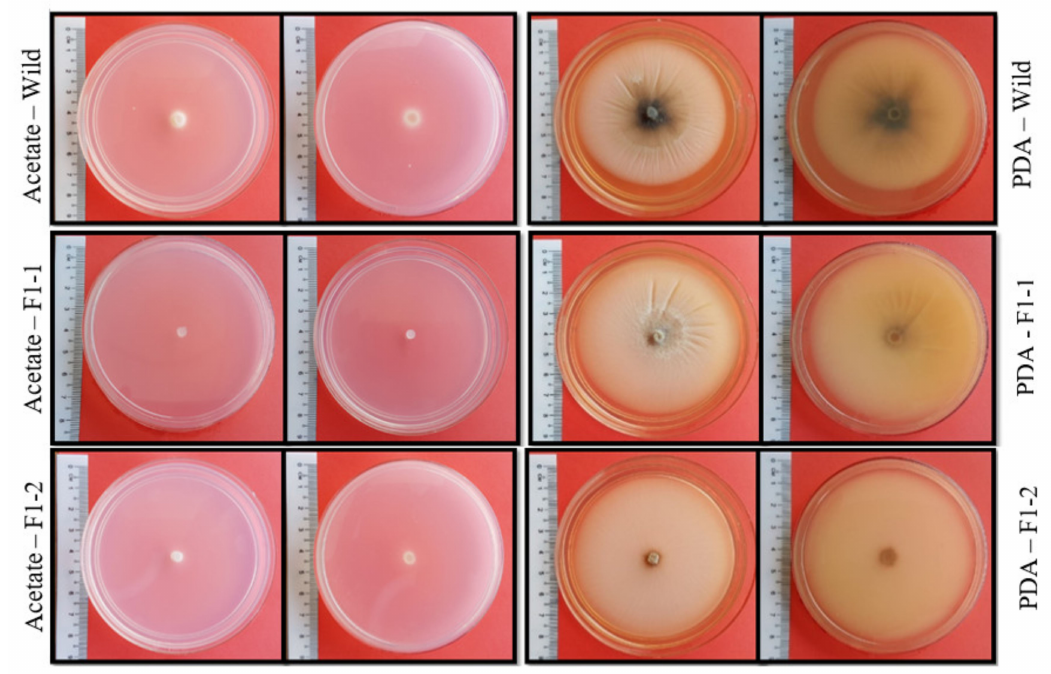
Figure 7. Pigments produced by wildtype and mutant M.oryzae S6 on di ff erent carbon sources. Appearance and vegetative growth of wildtype, fas1-1 and fas1- 2 after 10 days of incubation on di ff erent carbon sources at 26 ◦ C. ∆ fas1-1 and ∆ fas1-2 mutants showed lighter colony pigmentation and light-brown, whitish pigments compared to the blackish-brown colonies of the wildtype M. oryzae strain S6 on CM, PDA, MM supplemented with 50 mM glucose and MM supplemented with 50 mM olive oil.